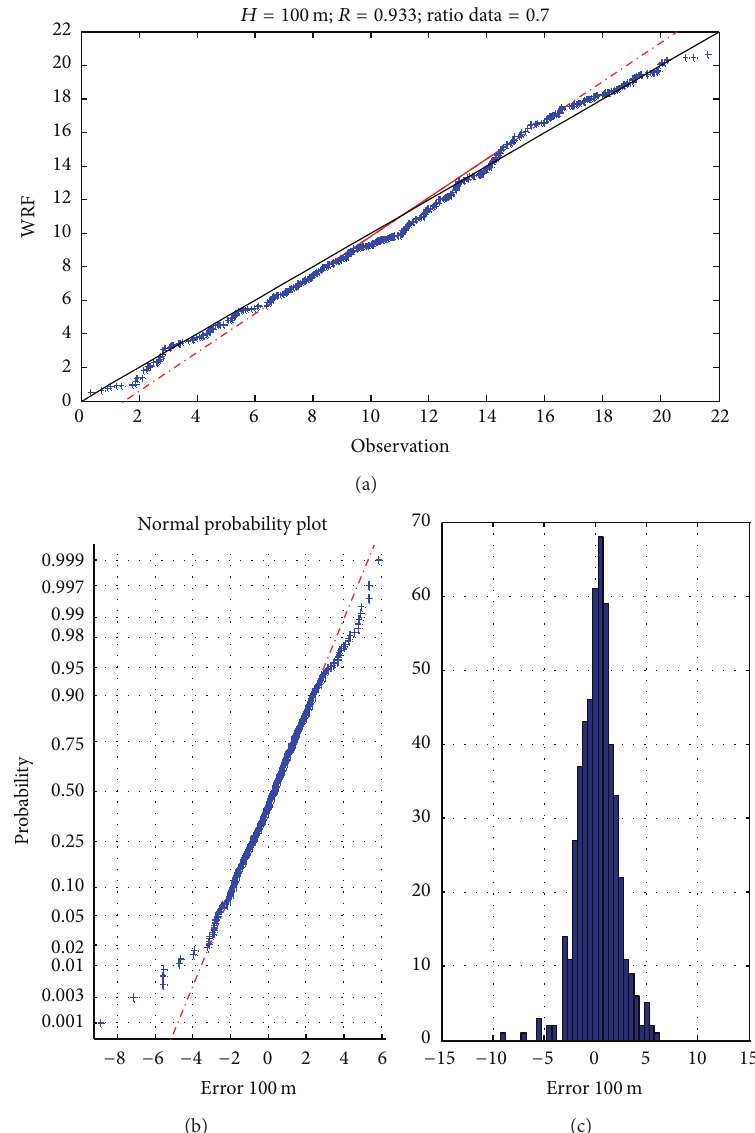
Figure 9: (a) Q-Q plot: the WRF MYNN PBL run ( y -axis) against the FINO1 100m wind speed distribution ( x -axis). (b) Normal distribution against the 100 m wind speed ME and (c) histogram of the wind speed